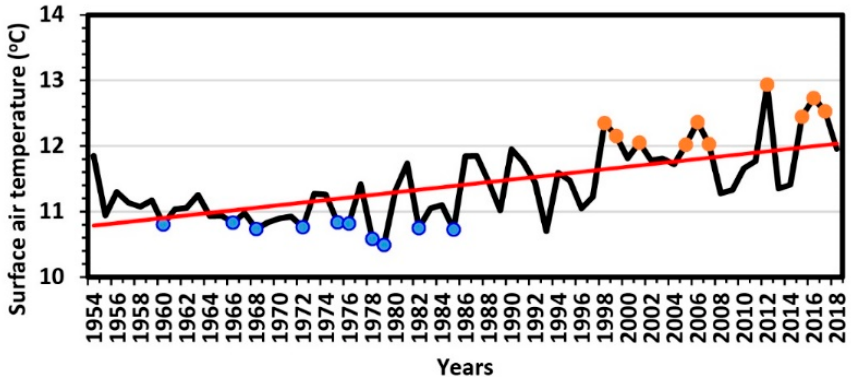
Figure 1. U.S. annual average surface air temperature ( ◦ C) over the time period 1954 to 2018. The 10 strongest positive anomaly years (denoted by solid orange circles) of 2012, 2016, 2017, 2015, 2006, 1998, 1999, 2001, 2007, and 2005, are referred to as the warmest years, and the 10 strongest negative anomaly years (denoted by solid blue circles) of 1979, 1978, 1985,1968, 1982, 1972, 1960, 1976, 1966, and 1975, are referred to as the coldest years.